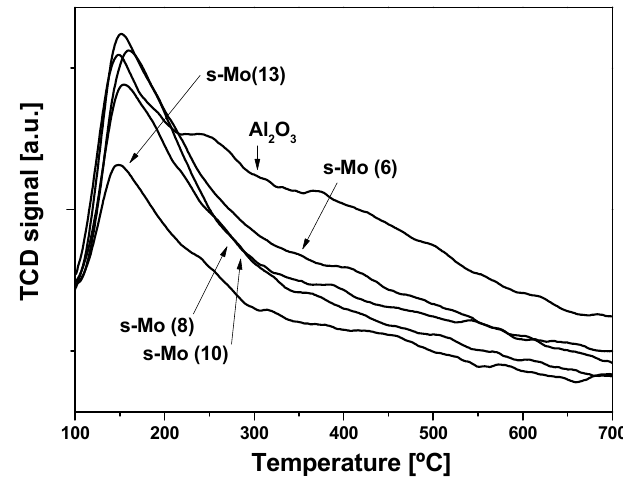
Figure 3. Temperature-programmed desorption of NH 3 (NH 3 -TPD) patterns of the samples indicated.